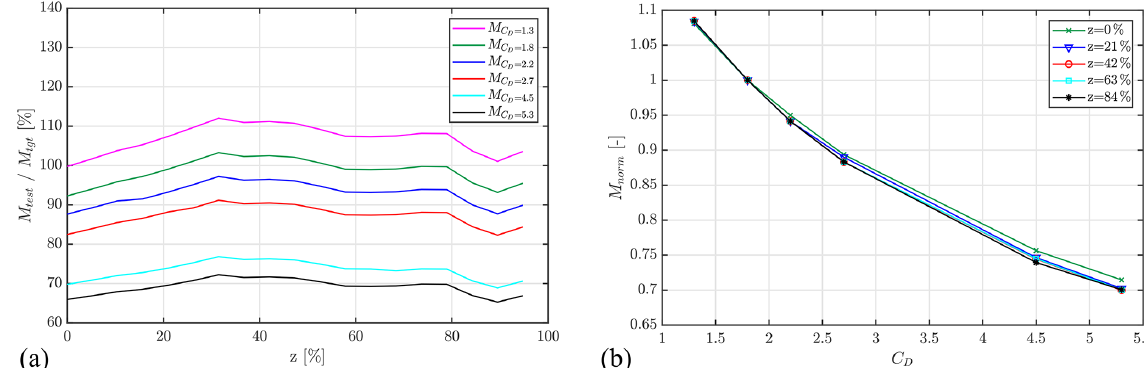
Figure 13. (a) Variation in the achieved flapwise test bending moment along the blade with respect to the target load for different drag coefficients and (b) variation in the test bending moment normalized against the root bending moment as a function of the drag coefficient for different blade span